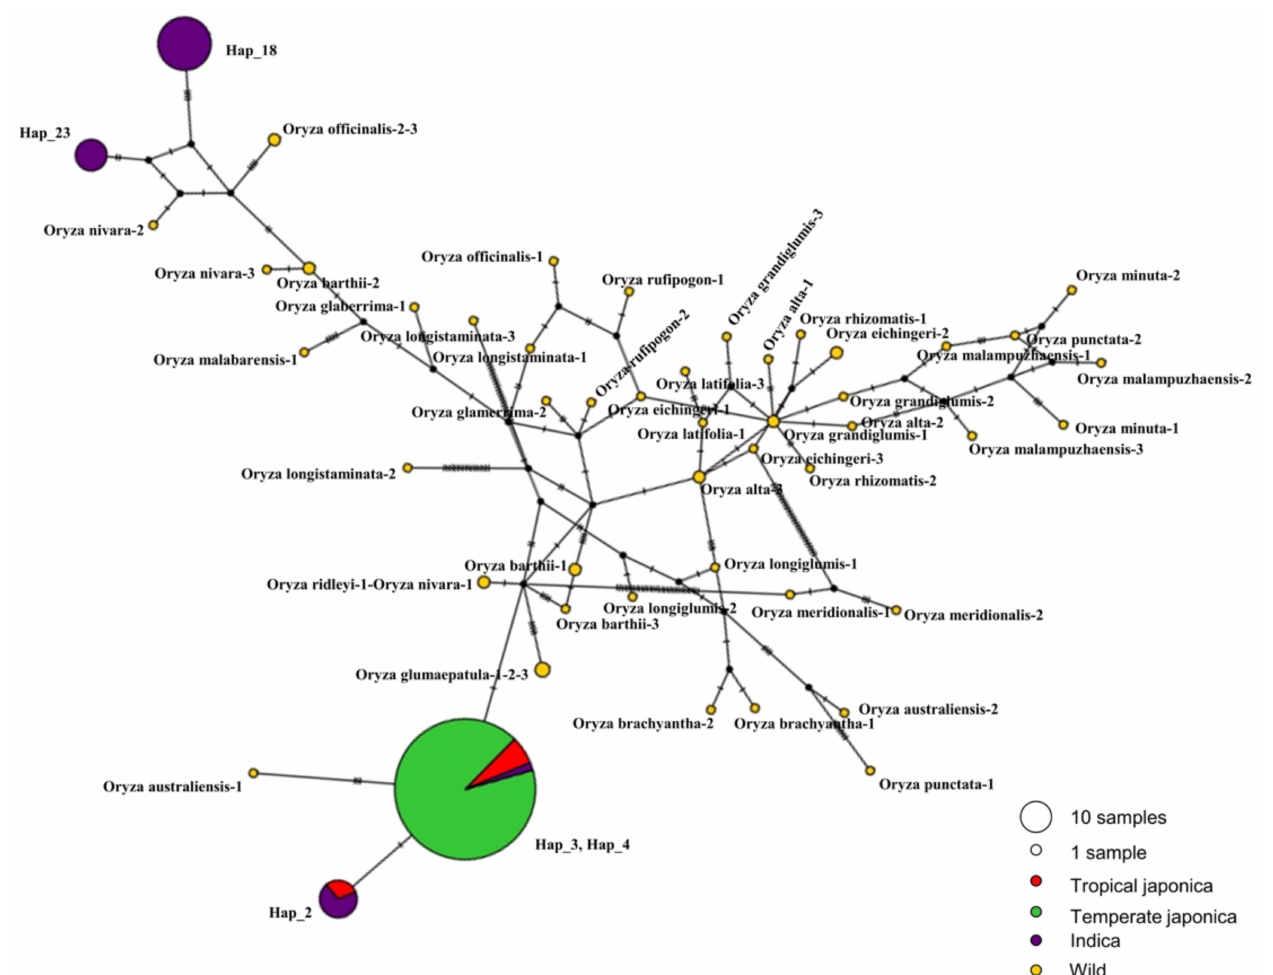
Figure 5. Haplotype network visualizing possible genotypic relationships of major cultivated haplogroups compared to wild rice haplotypes within the BADH1 region. The size of each circle is proportional to the accession numbers encompassed, and different colors indicate its ecotype. The median vectors indicated by the black circular dot is a hypothetical sequence used to connect the existing similar